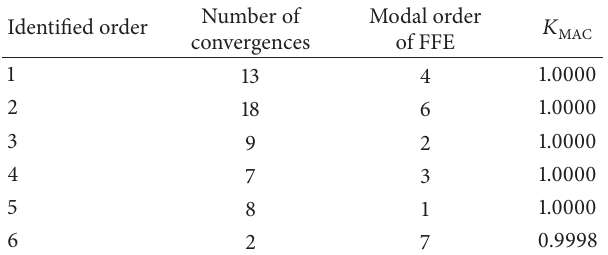
Table 6: The convergence times and MAC value of modal shapes.